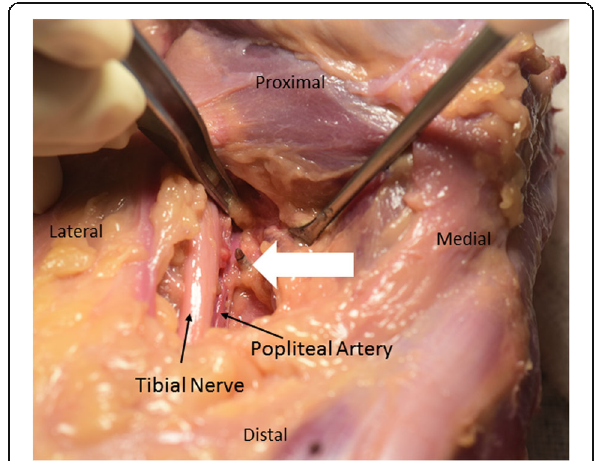
Fig. 2 Viewing from posterior to anterior of a left knee, showing the needle tip (white arrow) just adjacent to the popliteal artery and the proximity to the tibial nerve